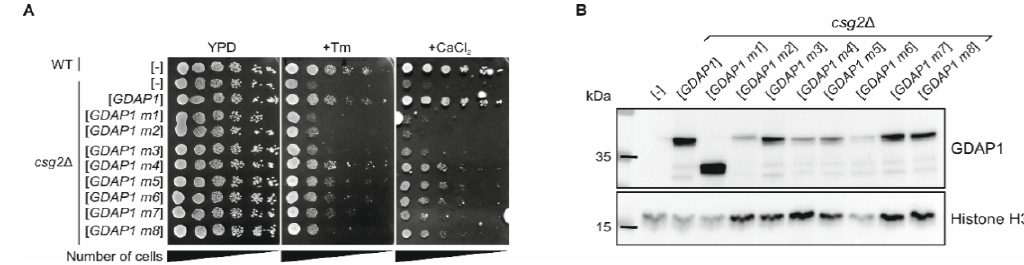
Figure 4. Possible yeast-based model of CMT4A disease for drug screen. ( A ) Overnight cultures of wild-type or csg2 ∆ yeast cells harboring empty vector ([-]) or plasmids with GDAP1 alleles were diluted to OD600 ≈ 1. Ten-fold serial dilutions were prepared and spotted on YPD media containing 0.5 µ g / mL tunicamycin (Tm) or 0.5 M calcium chloride (CaCl 2 ). Plates were incubated for 2 d (YPD and + Tm) or 6 d ( + CaCl 2 ) at 28 ◦ C. ( B ) The csg2 ∆ yeast strain harboring empty vector ([-]) or plasmids with GDAP1 alleles (as indicated) were cultured overnight in SC-leu medium at 28 ◦ C. Cells were then harvested and disrupted. Total cell extracts were analyzed by SDS-PAGE, followed by immunoblotting with anti-GDAP1 or anti-Histone H3 antibodies. Histone H3 was used as a loading control.